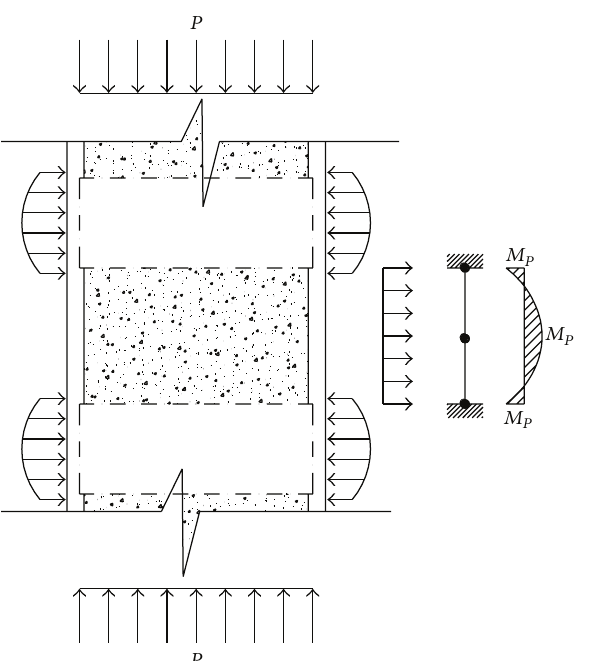
Figure 11: Crushing failure of concrete.